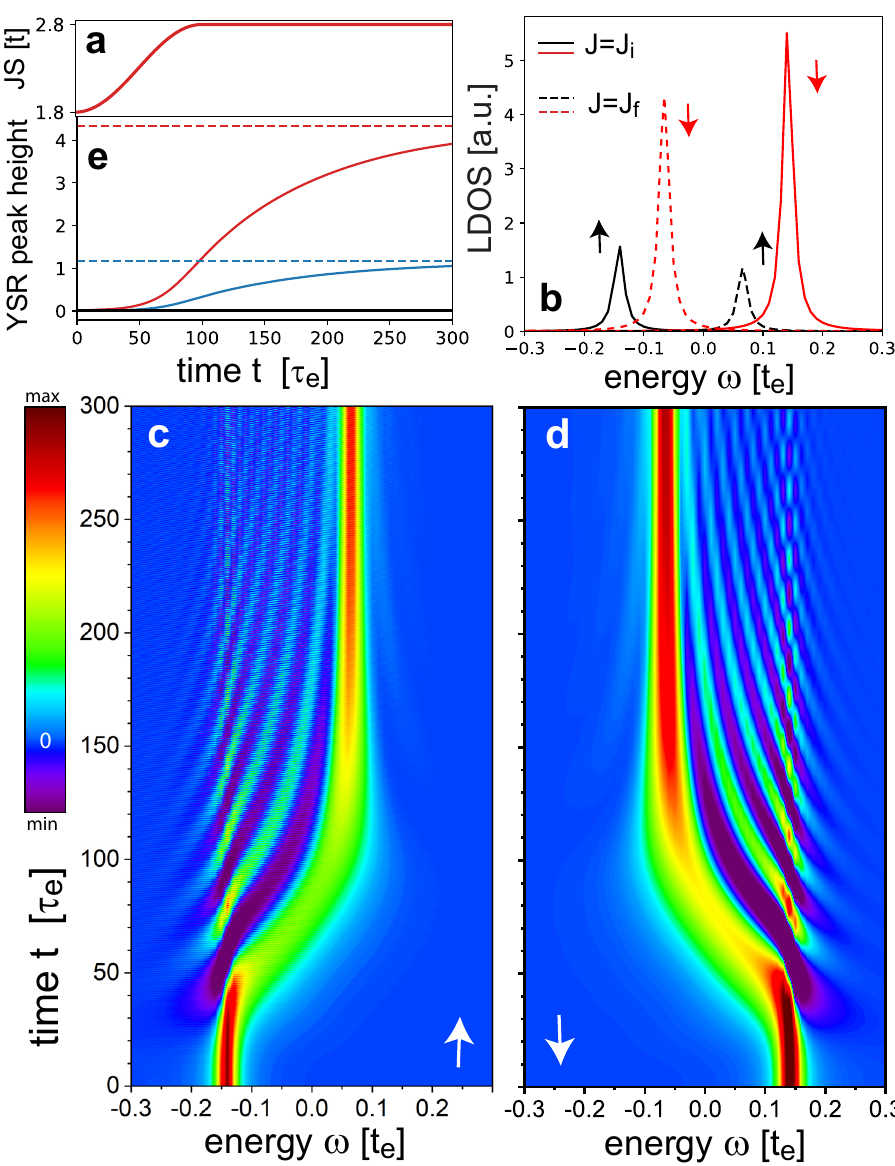
Fig. 2 Dynamical tuning of quantum phase transitions. a Time dependence of the magnetic coupling J ( t ) with an initial value of J i = 1.8 t e < J c , a fi nal value of J f = 2.8 t e > J c , where a quantum phase transition occurs at the critical magnetic coupling of J c = 2.45 t e , and the transition from J i to J f occurs over the time Δ t = 100 τ e . b Spin-resolved equilibrium local density of states (LDOS) in the presence of a single magnetic impurity with J i < J c and J f > J c . Time dependence of the spin-resolved non-equilibrium local density of states N neq ( σ , t , ω ) for c spin σ = ↑ , and d σ = ↓ arising from J ( t ) in a . The colorbar represents the normalized N neq . e Height of the Yu – Shiba – Rusinov (YSR) peaks as a function of time, representing the relaxation of the system. The results for N neq were obtained for a 24 × 24 site real space